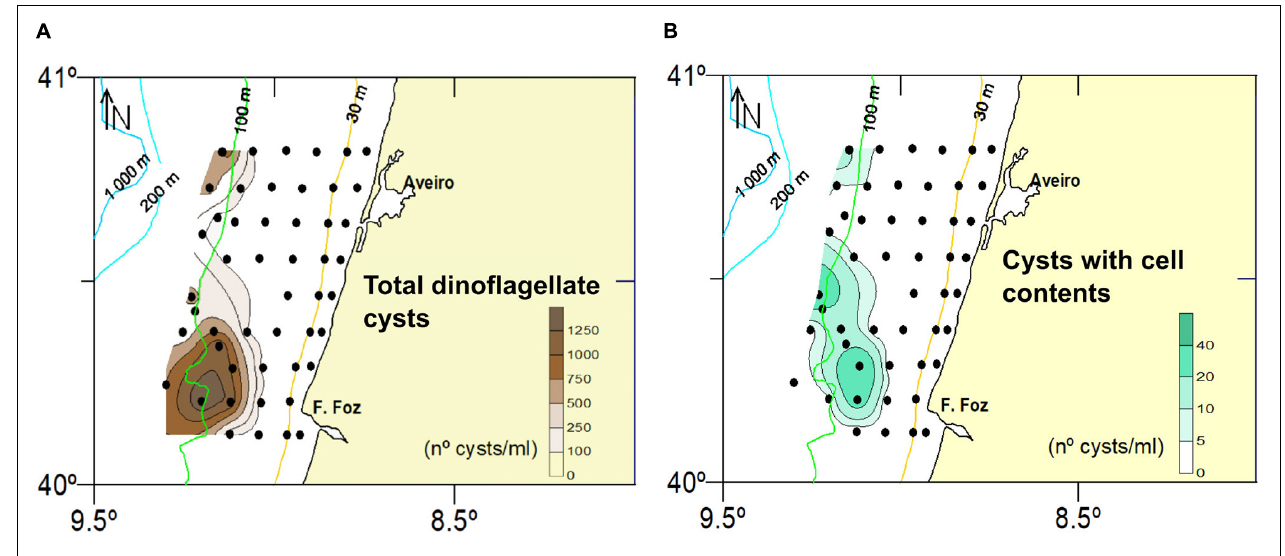
FIGURE 3 | Spatial distribution of concentrations of total cysts (A) and cysts with cell contents (B)